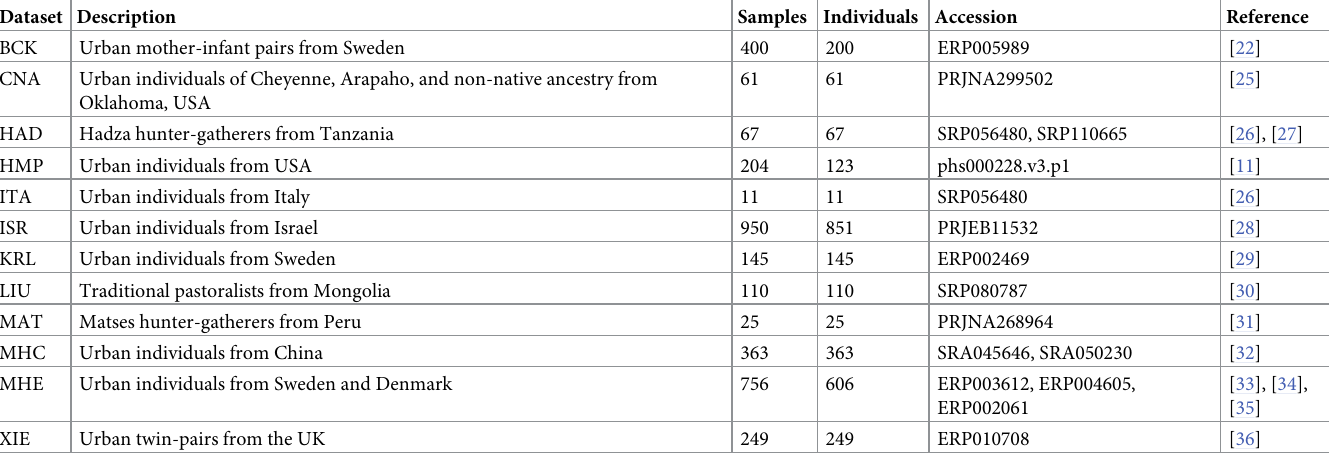
Table 1. Publicly available gut metagenomic datasets used in this